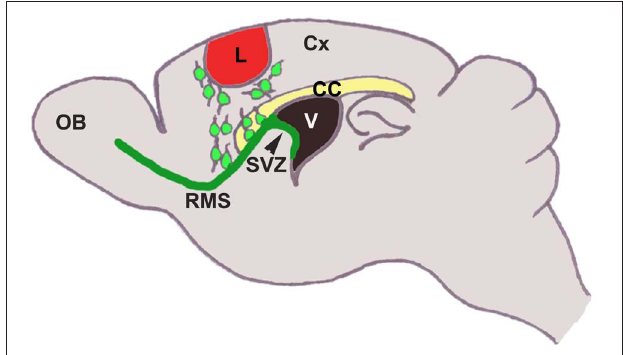
FIGURE 1 | In normal adults, neural stems cells in the SVZ (in green) proliferate to generate new neuroblasts. Neuroblasts migrate rostrally along the RMS (in green) to the olfactory bulb (OB). In response to cortical lesion (in red), a large number of neuroblasts migrate to the site of lesion. Lesion leads to upregulation of several molecules in the cortex around the injured area, which can affect this process. CC, Corpus Callosum; Cx, Cortex; L, lesion; V,